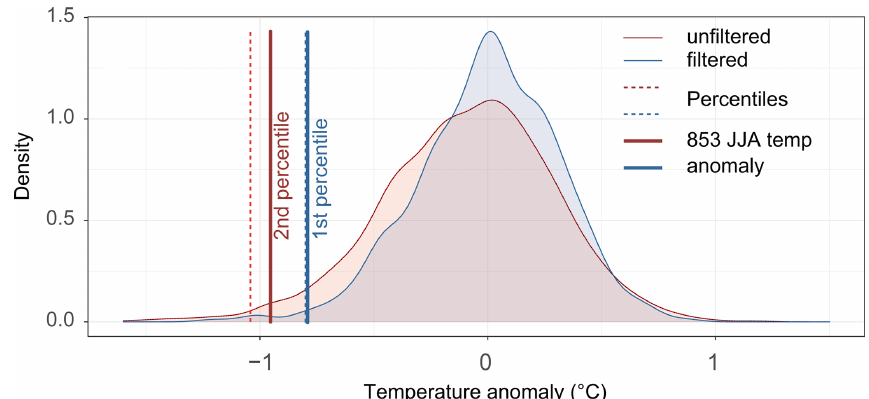
Figure F1. Distributions of JJA temperature anomalies in the unfiltered (red) and filtered (blue, 31-year moving average filter) 500–2000CE NH reconstructions. Blue and red vertical dotted bars indicate the 1st percentile of the filtered and the 2nd percentile of the unfiltered recon- structions, respectively. Blue and red bold vertical lines show the cooling observed in 853CE in the filtered and unfiltered reconstructions,